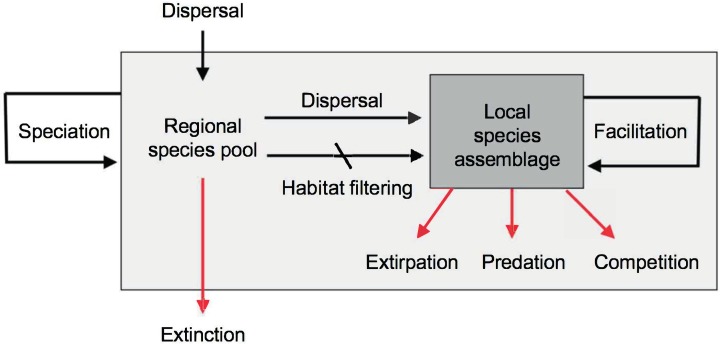
Main evolutionary and ecological processes contributing to the formation of species richness.The regional species pool (light gray box) is defined as the sum of all the local species assemblages (darker gray box). Black arrows indicate processes that increase species richness, red arrows processes that reduce species richness. Note the hierarchical organization of processes resulting in species richness, with evolutionary processes occurring over regional to continental spatiotemporal scales and ecological processes occurring over local scales. Speciation and dispersal contribute new species to the regional pool, while extinction removes species. Dispersal mediated by abiotic habitat filtering and biotic facilitation (Kraft & Ackerly, 2014) increase the richness of local assemblages by enhancing establishment of species preadapted to local conditions, or aiding in the establishment of other species. Biotic interactions such as predation and competition may serve to reduce local richness. Diagram modified from Schluter & Ricklefs (1993) and Albert, Val & Hoorn (in press).